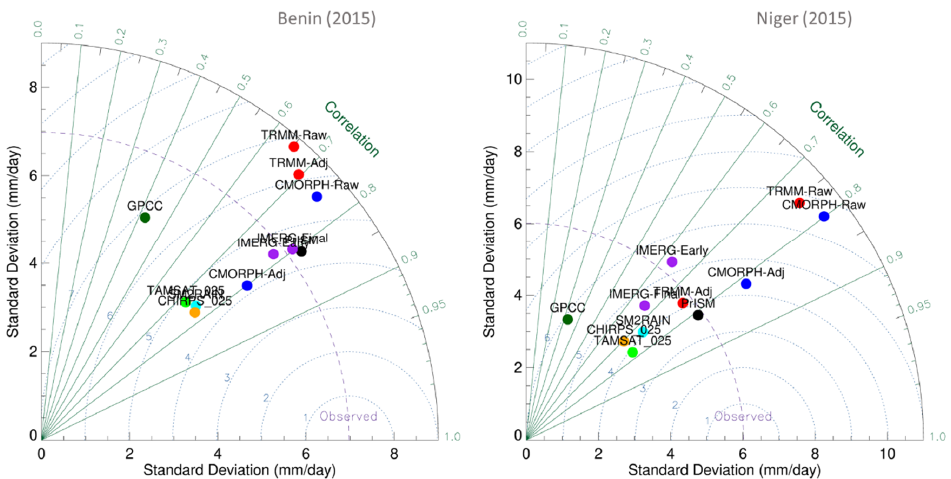
Figure 4. Taylor diagrams for the Benin ( left ) and Niger ( right ) 0.25° sites for the year 2015 for the 11 precipitation products. Color dots refer to the different products (blue = CMORPH, red = TRMM, purple = IMERG, green = TAMSAT_025, cyan = SM2RAIN, orange = CHIRPS, dark green = GPCC and black = PrISM). Statistical scores are given in Table 3.